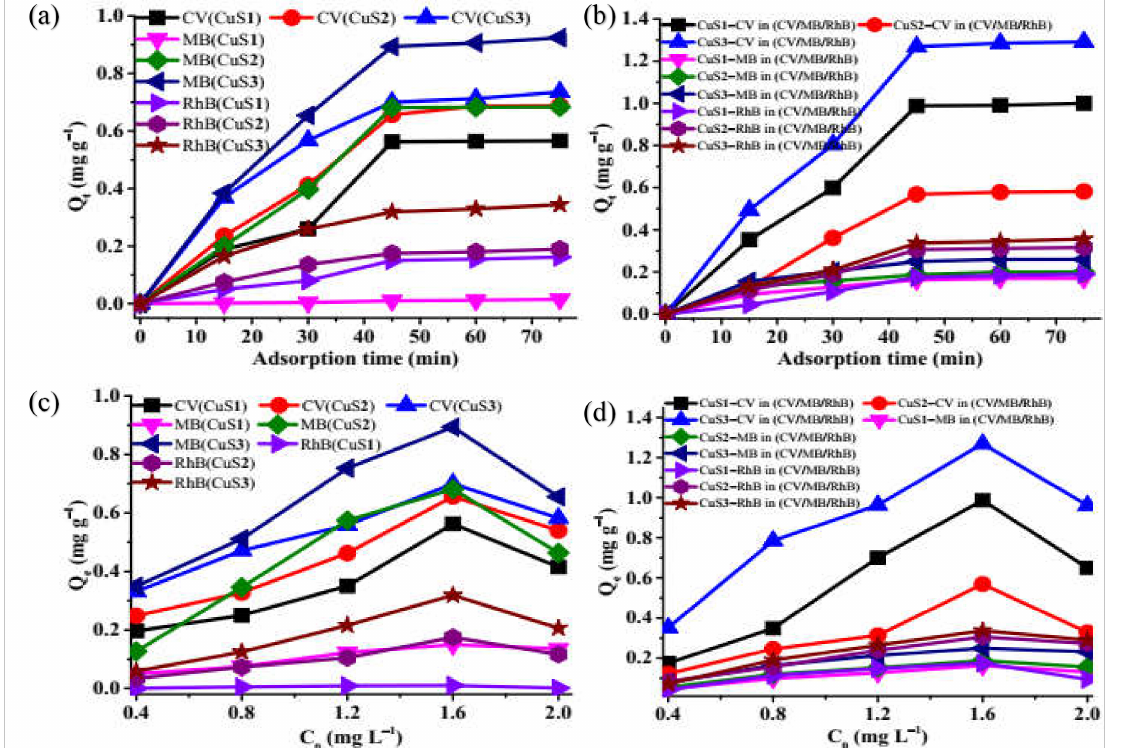
Figure 4. Time profile adsorption capacity ( a , b ) and catalytic dosage adsorption capacity ( c , d ) of CuS over single and mixed